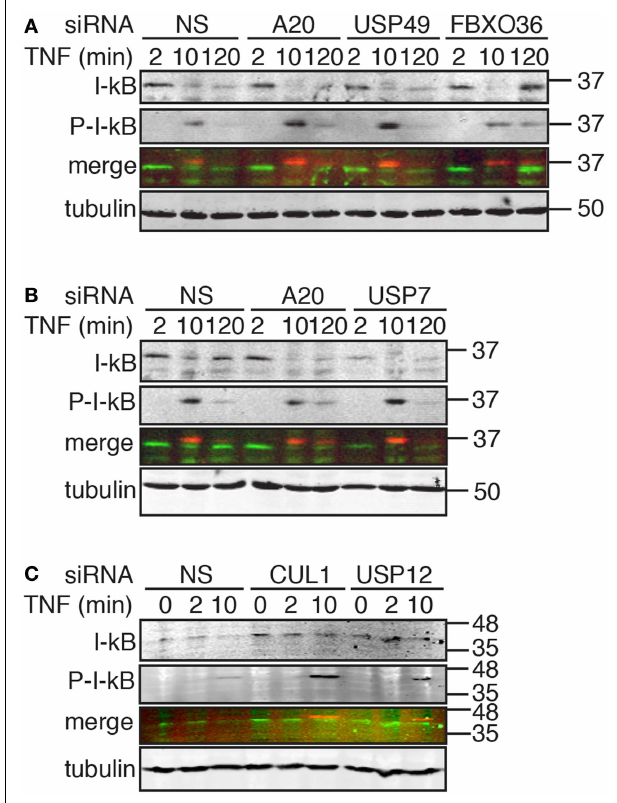
FIGURE 8 |Western blot evaluation of total I- κ B and phosphorylated I- κ B (P-I- κ B) in cells treated with the indicated siRNAs and incubated withTNF for the indicated times . In the merged images, I- κ B is shown in green and P-I- κ B is shown in red.Tubulin is shown as a loading control and numbers on the side indicate molecular weights in